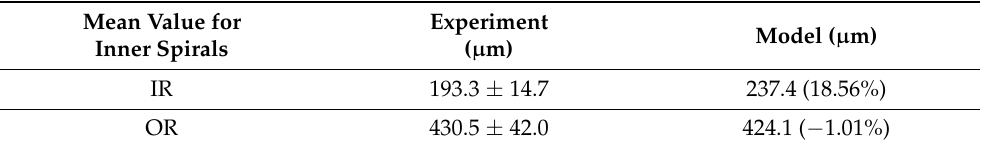
Table 3. Comparison of the inner and outer radii, experimentally analyzed, and their prediction by the model. IR = inner radius; OR = outer radius. N =